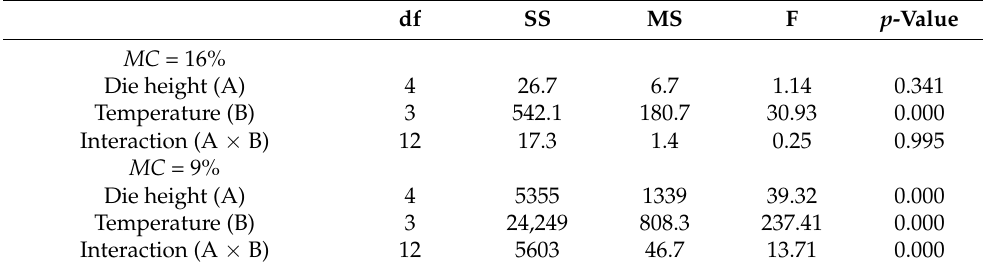
Figure 4. The changes of relaxation coefficient values [%] for moisture content 16% ( a ) and moisture content 9% ( b ). The statistical analysis for moisture content MC = 9% confirmed the influence of all input parameters on the value of the relaxation coefficient (Table 4). Table 4. Results of ANOVA analysis for the relaxation coefficient for two moistures.